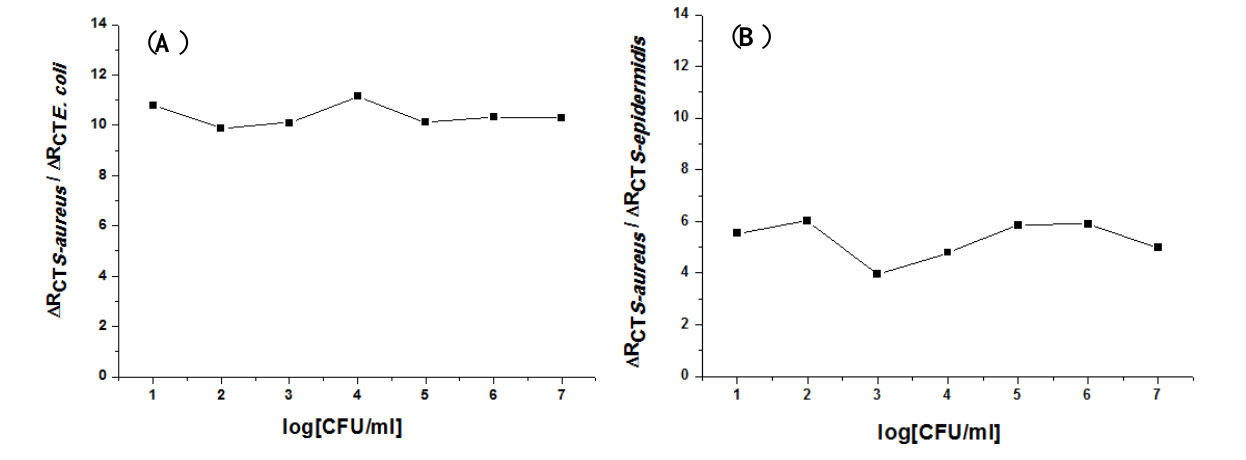
Figure 8. Positive-to-negative response ratio of the developed immunosensor for ( A ) E. coli , and ( B ) S. epidermidis